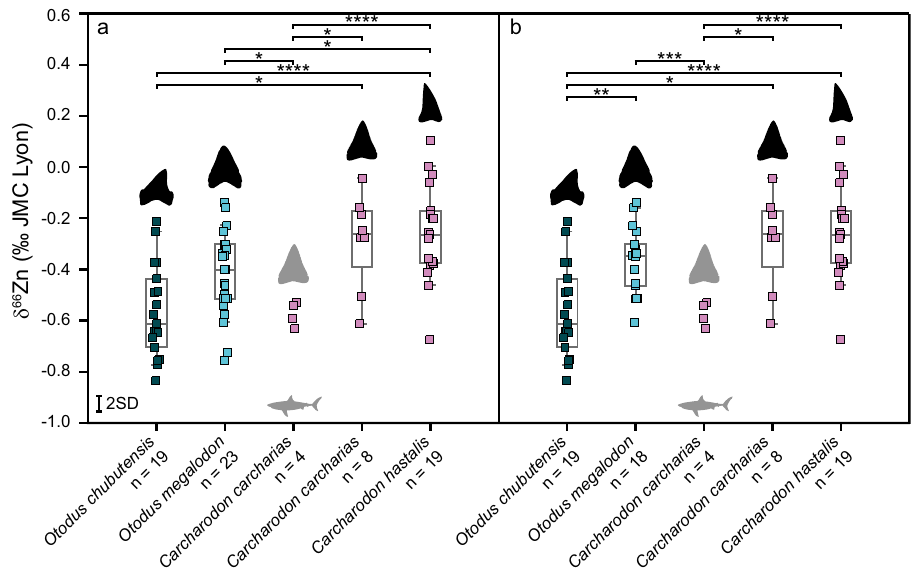
Fig. 4 Results from post-hoc Games-Howell pairwise comparisons of δ 66 Zn values of enameloid from fossil and extant Otodus spp. and Carcharodon spp. All assemblages and ages are combined for a given species, except for extant C. carcharias . Extant C. carcharias teeth are indicated with grey silhouettes. a Includes all O. megalodon populations, whereas ( b ) excludes the Japanese (Paci fi c) population, focusing on Atlantic and Tethys/Paratethys populations only. The boxes for n > 5 represent the 25th – 75th percentiles (with the median as a horizontal line), and the whiskers show the 10th – 90th percentiles. Signi fi cance level is indicated by “ * ” ( p value < 0.05), “ ** ” ( p value < 0.005), “ *** ” ( p value < 0.0005) and “ **** ” ( p value < 0.00005). Measurement uncertainty is indicated at the 2 SD level. See also Supplementary Tables 11, 12. Otodus chubutensis (dark blue) and O. megalodon teeth (light blue) are coloured separately. All other samples are colour-coded following their genus. Source data are provided as a Source Data fi le. Silhouettes are not to